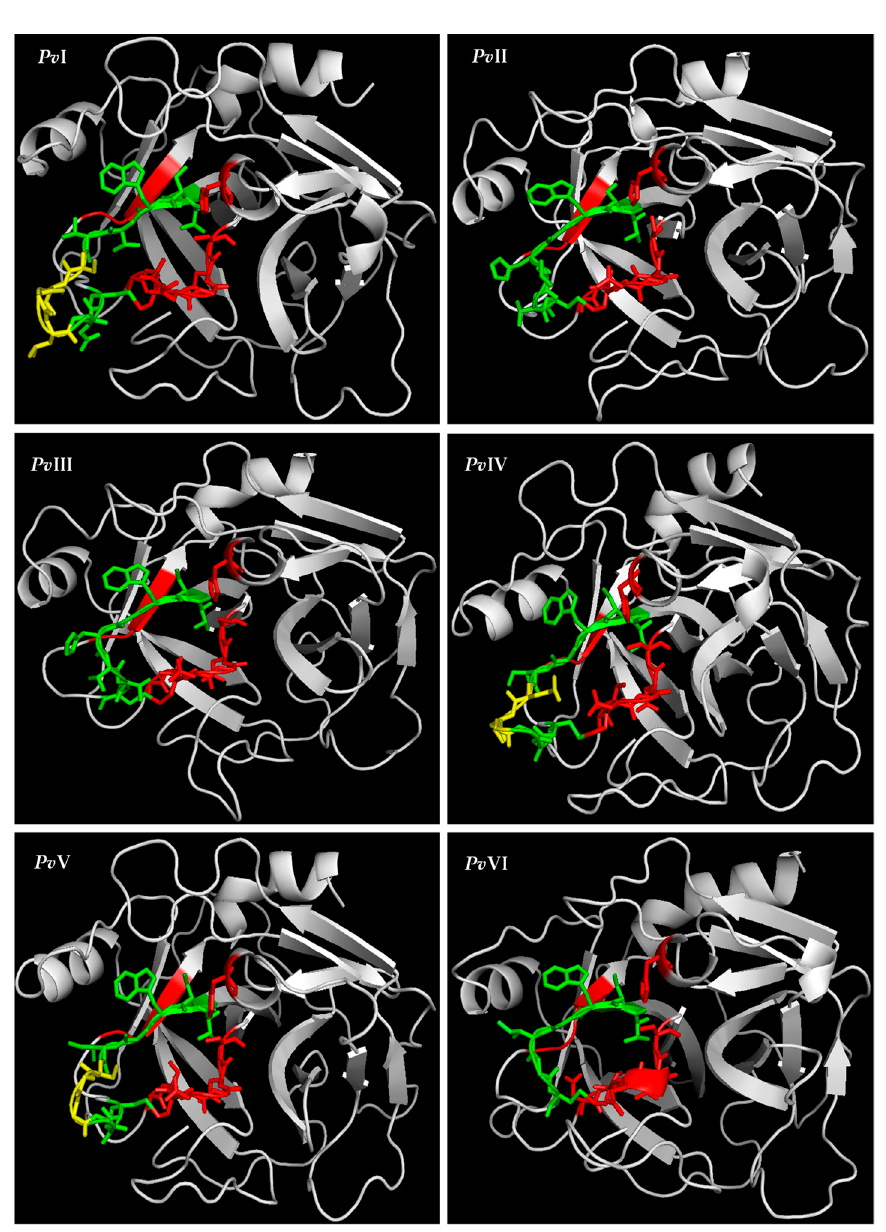
Figure 12. The S1 specificity pocket of six predicted 3D structures are shown in the colored regions.